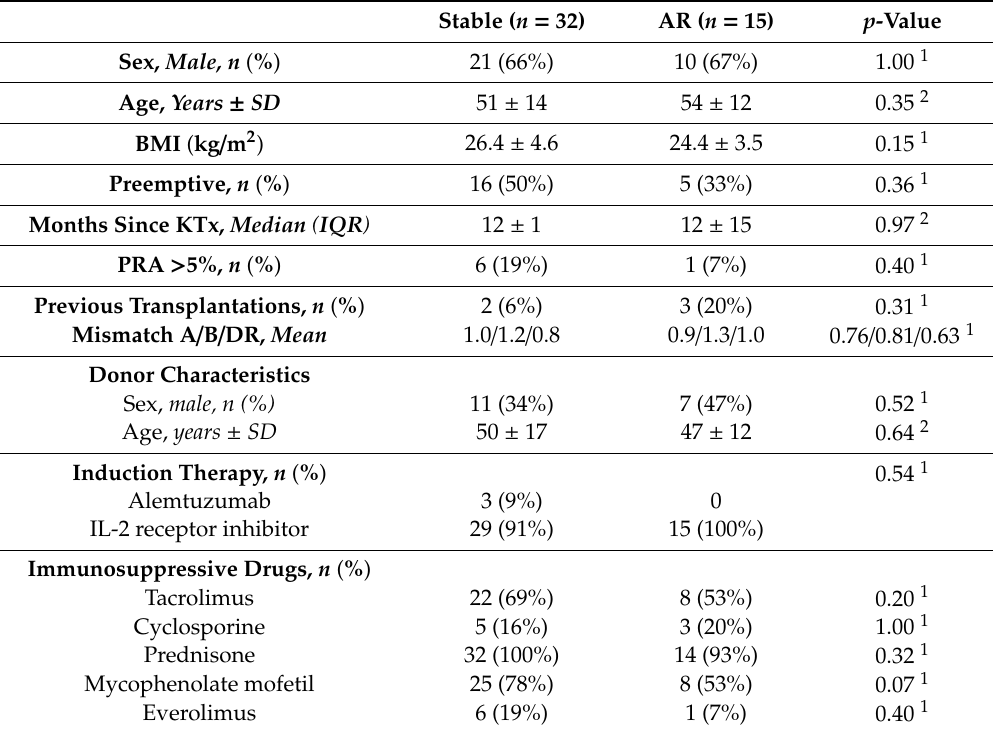
Figure 1. Decreased capillary density after acute rejection. ( A ) Representative images of CD34 staining for pre-transplantation and acute rejection (AR) biopsies. ( B ) Quantification of CD34 staining (PreTx, n = 78; AR, n = 102). ( C ) Representative images of CD73 staining for pre-transplantation and acute rejection (AR) biopsies. ( D ) Quantification of CD73 staining (PreTx, n = 66, AR, n = 29). *** p -value < 0.001. Table 1. Cross-sectional study patient characteristics of patients with a stable kidney transplant function (stable) and patients with acute rejection